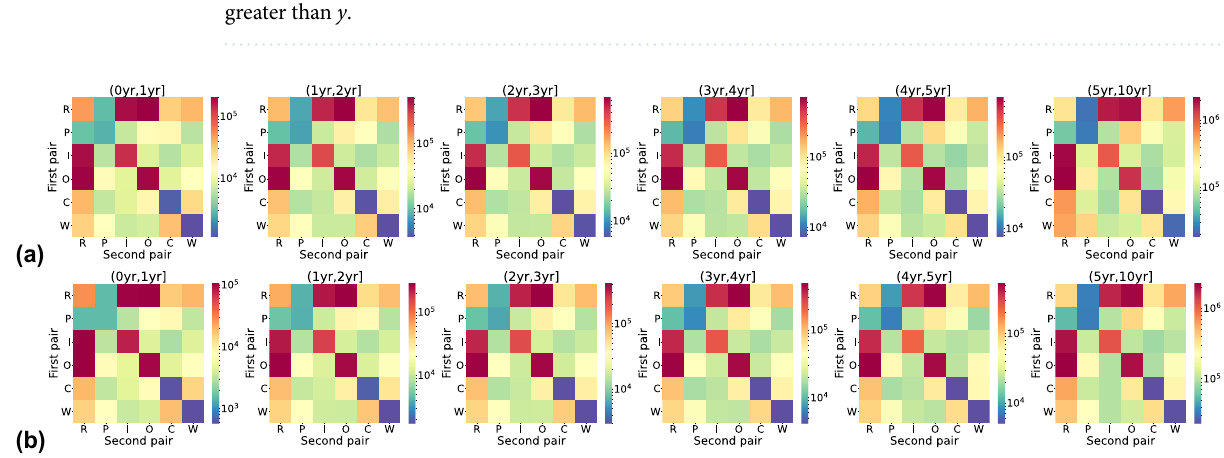
Figure 4. The number of 2-node 3-event and 3-node 3-event motifs in the opposition network for a range of (cid:31) C values ( a ) or for a range of (cid:31) W values ( b ). For each heatmap, ( x , y ] indicates the values of the timing threshold, i.e., we only count the motifs for which � C ∈ ( x , y ] and (cid:31) W = 10 years in panel ( a ), and � C = � W ∈ ( x , y ] in panel ( b ). Each cell in the heat map corresponds to a type of 3-event motif, where the row shows the first pair of events (i.e., the first two of the three events constituting the 3-event motif) and the column shows the second pair of events (i.e., the second and third events in the same motif). The color indicates the motif